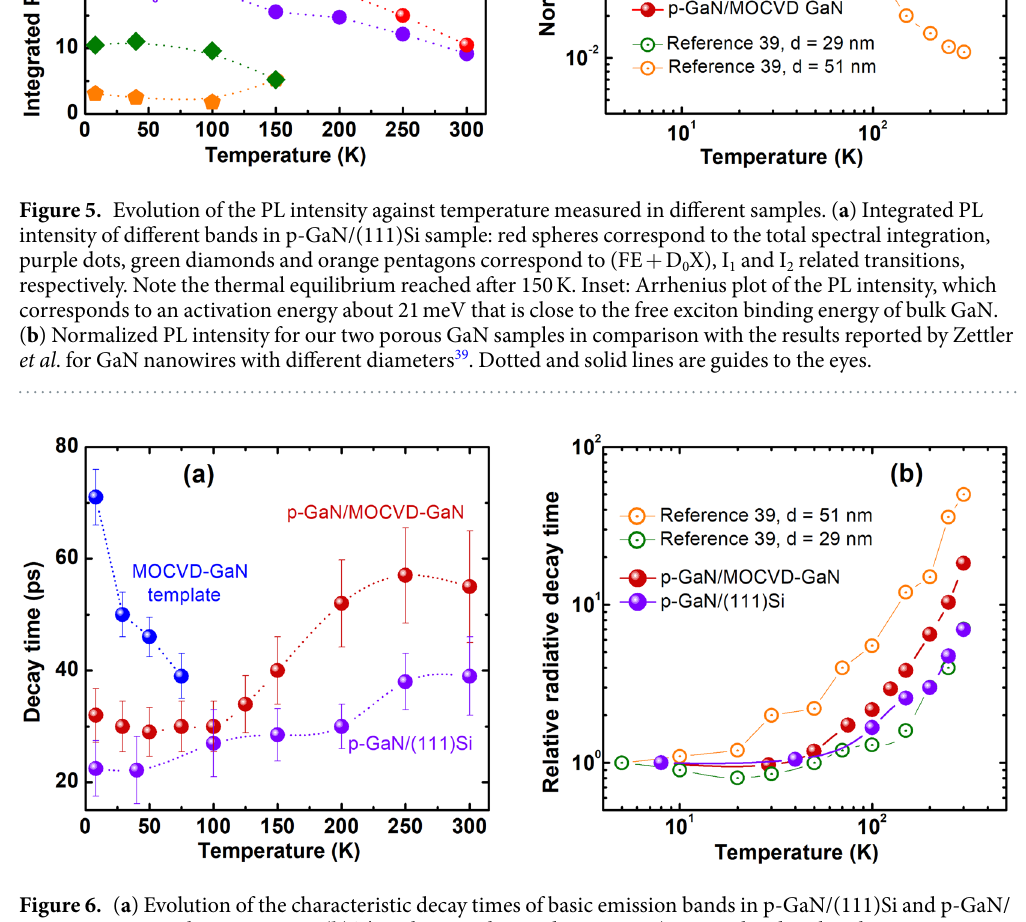
Figure 6. ( a ) Evolution of the characteristic decay times of basic emission bands in p-GaN/(111)Si and p-GaN/ MOCVD-GaN with temperature. ( b ) The relative radiative decay times (renormalized to their low temperature values) of our porous GaN in comparison with the results reported by Zettler et al . for GaN nanowires with different diameters 39 , as a function of temperature. Dash and solid lines are guides to the eyes. The notations of marks are given in the